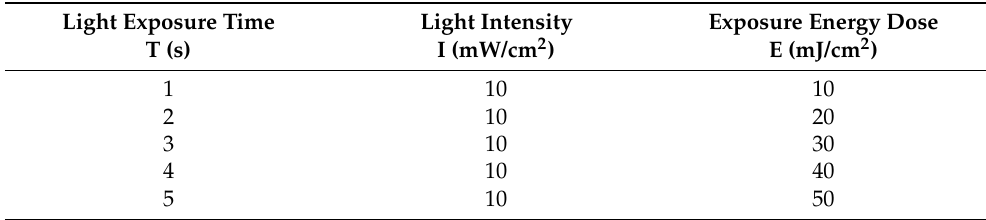
Table 1. Exposure parameters used for a series of experiments designed to control cure depth and excess cure width in which E = I ×